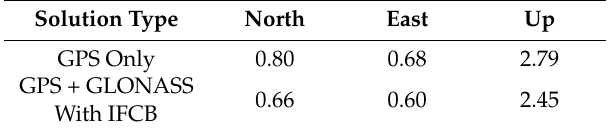
Table 6. Position RMS (cm) for kinematic ambiguity fixed PPP